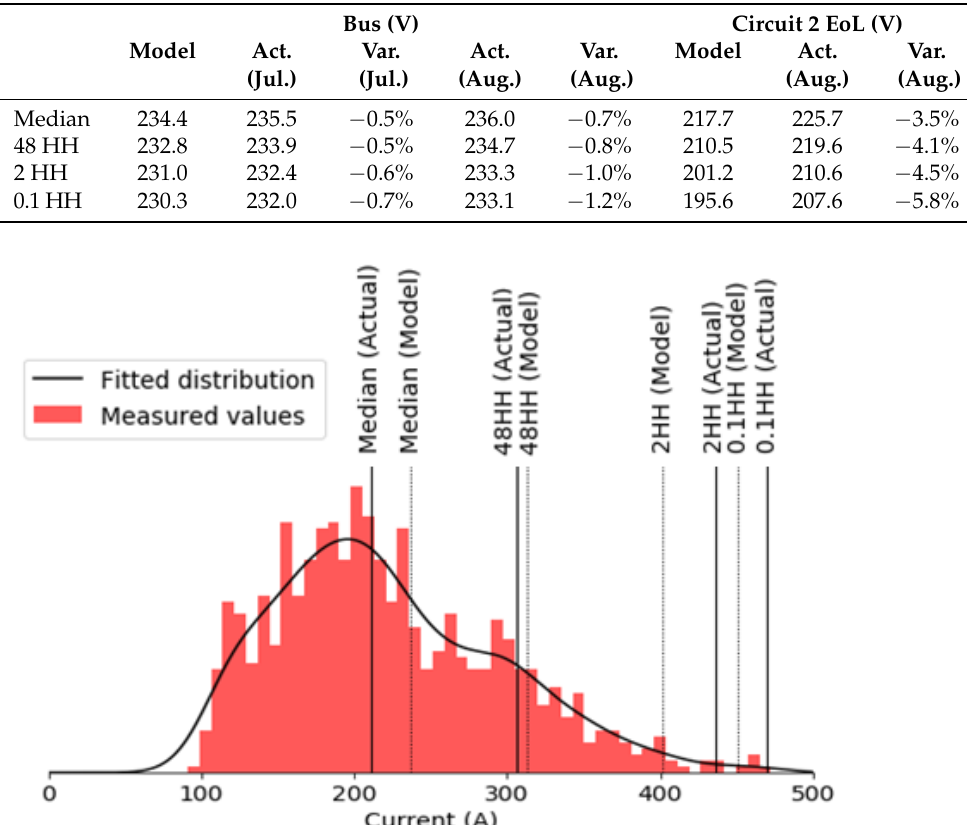
Figure 8. Comparison of modelled versus measured current distributions for circuit 2 over the peak winter week. Key percentiles are marked on the graph, with dotted lines for simulation results and solid lines for measured results.